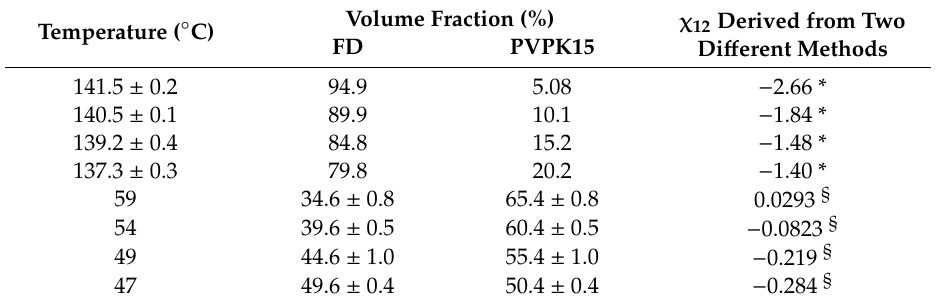
Table 4. Data of F–H interaction parameter χ 12 ( Φ 1 , T) for FD-PVPK15 obtained via both AAPS (low temperatures) and dissolution / melting depression (high temperatures) methods. ( n =